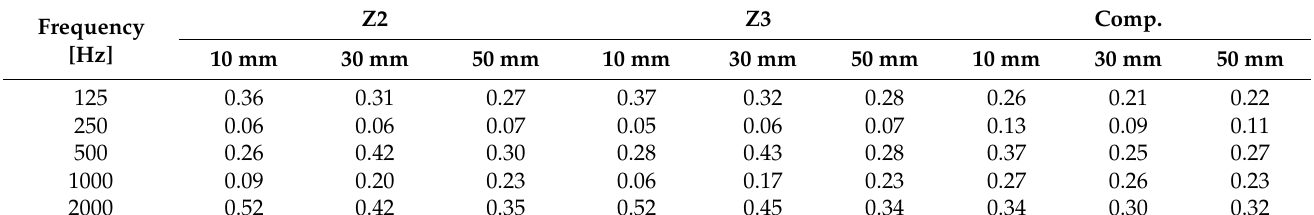
Table 3. Determination of sound absorption of cement composites.